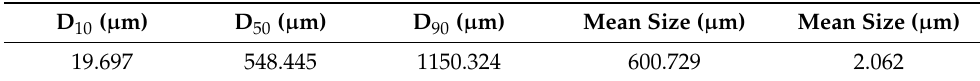
Figure 2. Particle size distribution. Table 1. Basic parameters for the particle size distribution.